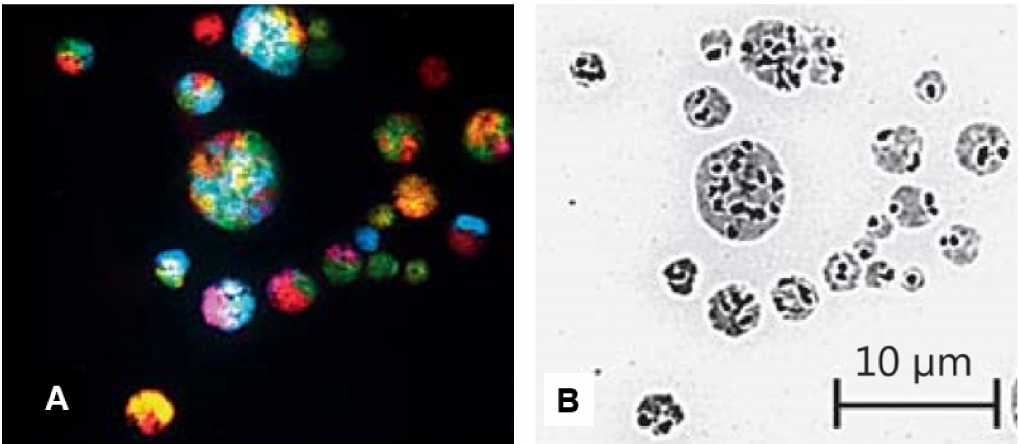
Figure 3. Spectral karyotyping (SKY) image of a micronuclei cluster. Panel A is the SKY (spectral karyotyping) image of a micronuclear cluster. Di ff erent colors represent di ff erent chromosomes. While the two biggest micronuclei contain numerous chromosomes, most of the smallest micronuclei only contain single chromosome (indicated by one color). Panel B is the same image with reversed DAPI staining. The strong black dot signals represent the centromere (suggesting that all nuclei of this cluster contain a centromere). This micronuclear cluster was observed from re-cultured cell population of mouse ovarian surface epithelial (Brca1 - / - and p53- / -) cells. Following the treatment of Doxorubicin (2 µ g / mL, for 2 h). Figure 3 is reused from reference [12], with permission from